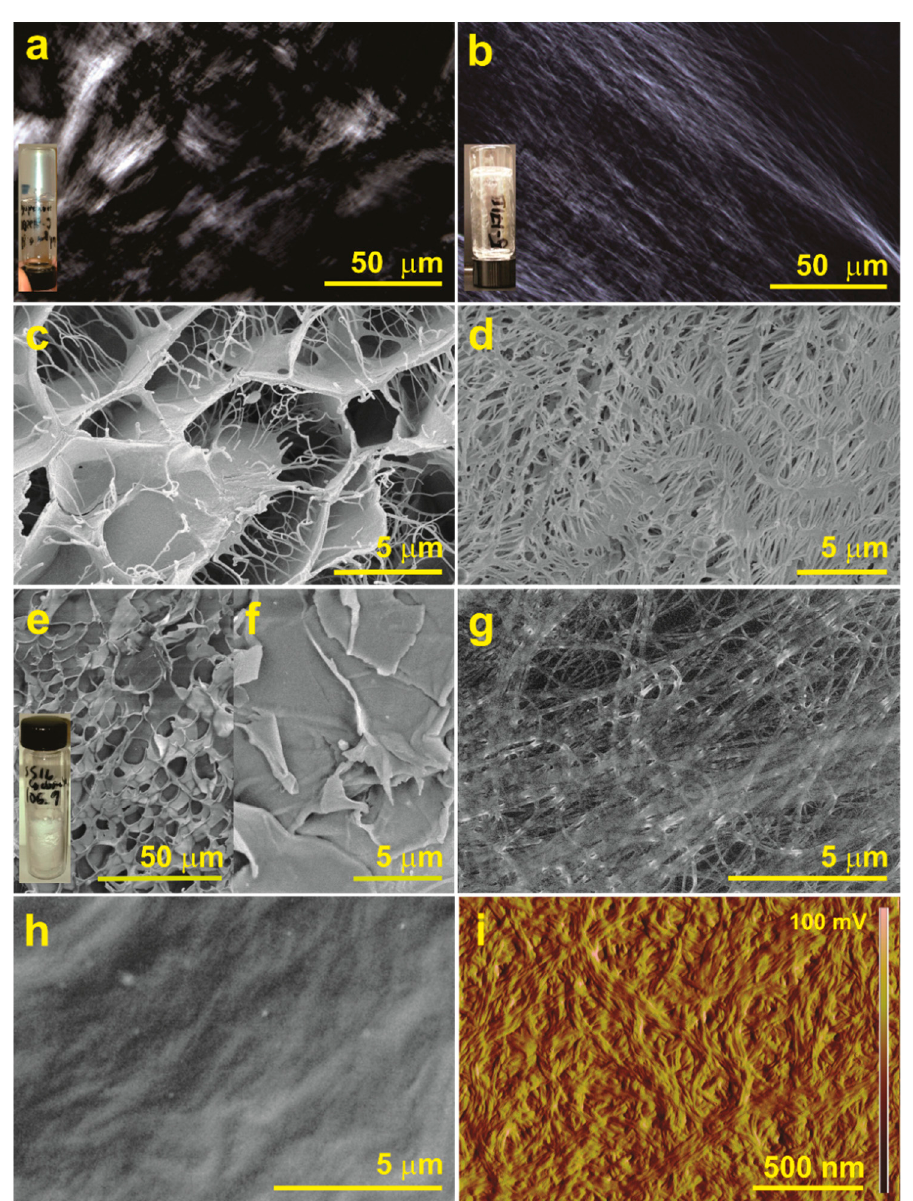
Figure 7. Microscopy images of SAFINs of ISA24 . POM images of organogels of ISA24 with ( a ) cyclohexane and ( b ) toluene (2 wt%). Freeze-fractured cryo-SEM images of in situ aerogels of ISA24 from ( c ) cyclohexane and ( d ) toluene organogels (2 wt%). SEM images of an ex situ, freeze-dried aerogel of ISA24 from a cyclohexane organogel (2 wt%) at 23 ° C ( e , f ). SEM images of dense, in situ xerogels of ISA24 from ( g ) toluene and ( h ) cyclohexane (2 wt%) at 23 ° C. AFM amplitude images of a thick in situ xerogel of ISA24 from cyclohexane (2 wt%) ( i ). The difference in the morphology of the SAFINs of ISA24 formed from cyclohexane versus toluene are likely due to the large difference between the freezing points